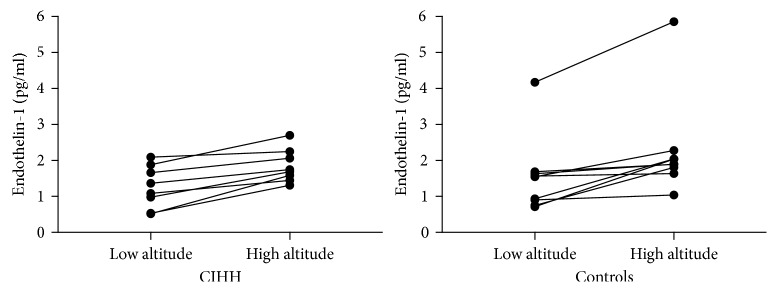
Endothelin-1 at lowland and high altitude. Endothelin-1 serum levels increased at high altitude compared to lowland in CIHH as well as in controls (p < 0.01 in both groups, by t-test, paired). There was no significant difference between CIHH and controls. Measurements at lowland and altitude from each individual are connected by a line.